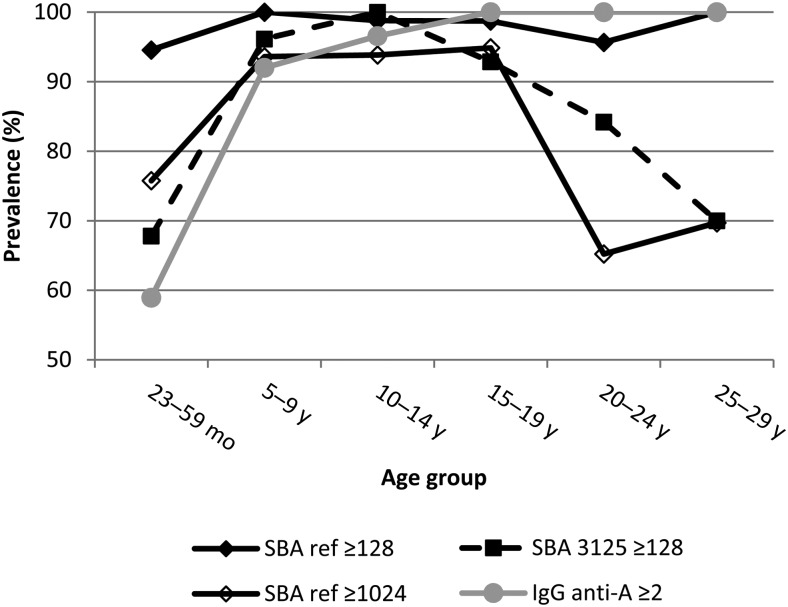
Seroprevalence according to different serologic outcomes among the population aged 23 months to 29 years, by age group, Bobo-Dioulasso, Burkina Faso, 2011. Included are all 481 study participants who were eligible for meningococcal group A conjugate vaccination during 2010. Abbreviations: anti-A, against meningococcal serogroup A; IgG, immunoglobulin G; SBA, serum bactericidal antibody.